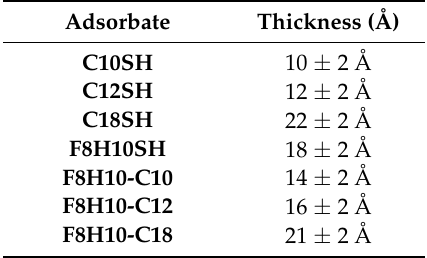
Table 2. Ellipsometric thickness measurements for SAMs on gold derived from the monodentate thiols and the F8H10-Cm dithiols.